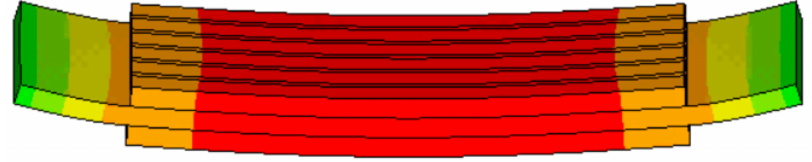
Figure 5. The vibration mode of the trilaminar